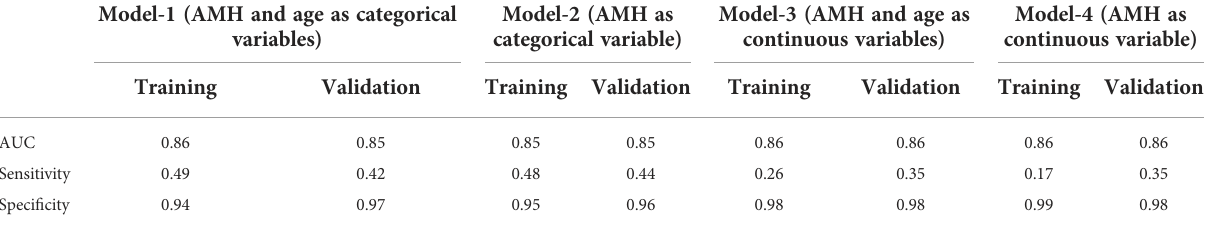
TABLE 5 Comparison of different models using AMH or not, or using AMH as categorical variable or not. Model-1 (AMH and age as categorical